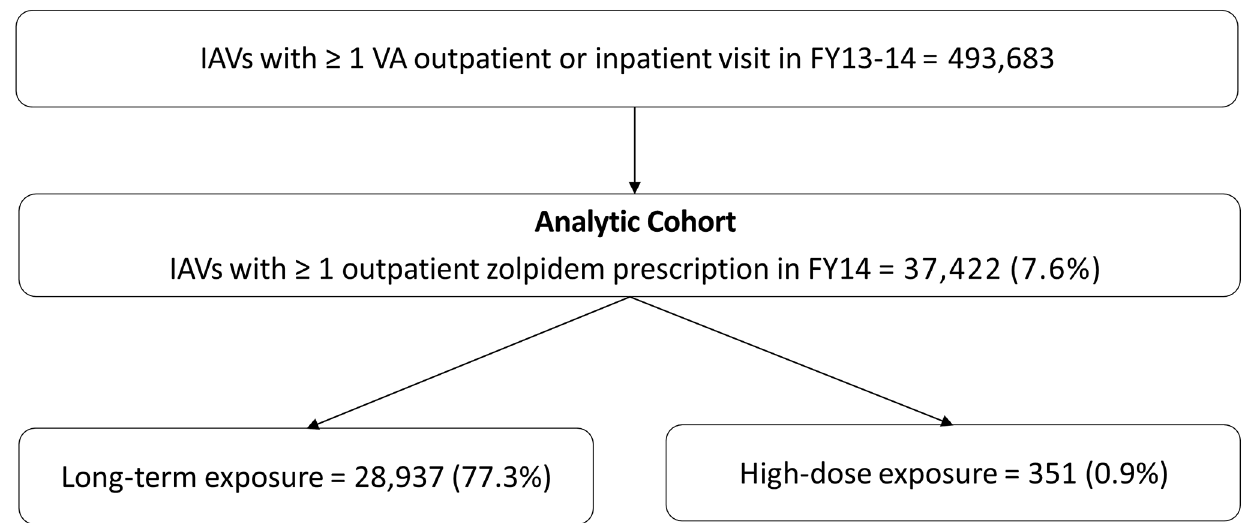
Fig 1. Derivation of study cohort of Iraq and Afghanistan veterans with zolpidem exposure in fiscal year 2014.